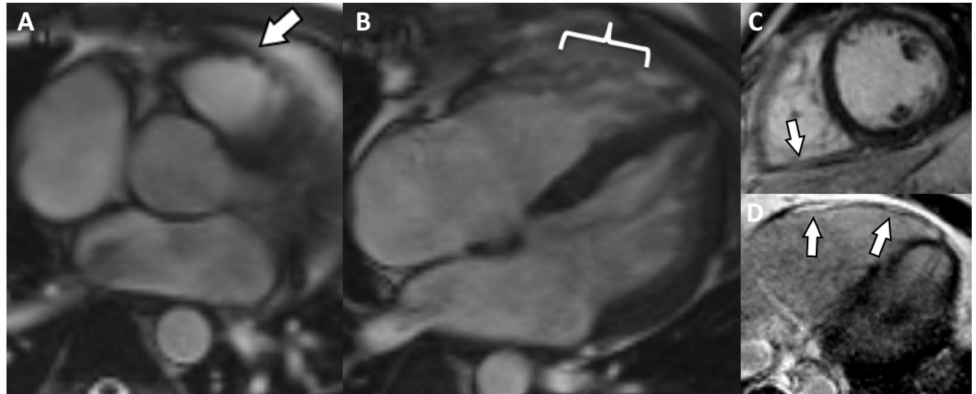
Figure 7. ( A ) Axial Cine-GRE sequence: focal dyskinesia of the RVOT; ( B ) four-chamber Cine-GRE sequence, systole: focal dyskinesias of the lateral wall of the RV, above the insertion of the moderating band; ( C ) PSIR delayed postcontrast sequence short-axis: diffuse LGE of the lateral wall of the RV, focal LGE of the inferior wall (arrow); ( D ) Axial delayed postcontrast PSIR sequence: LGE of the lateral wall of the